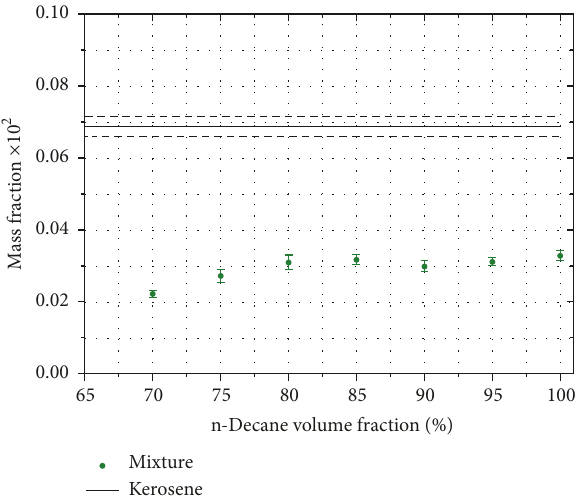
Figure 7: Comparison of mass fraction of H2 for the surrogate and the kerosene burning.